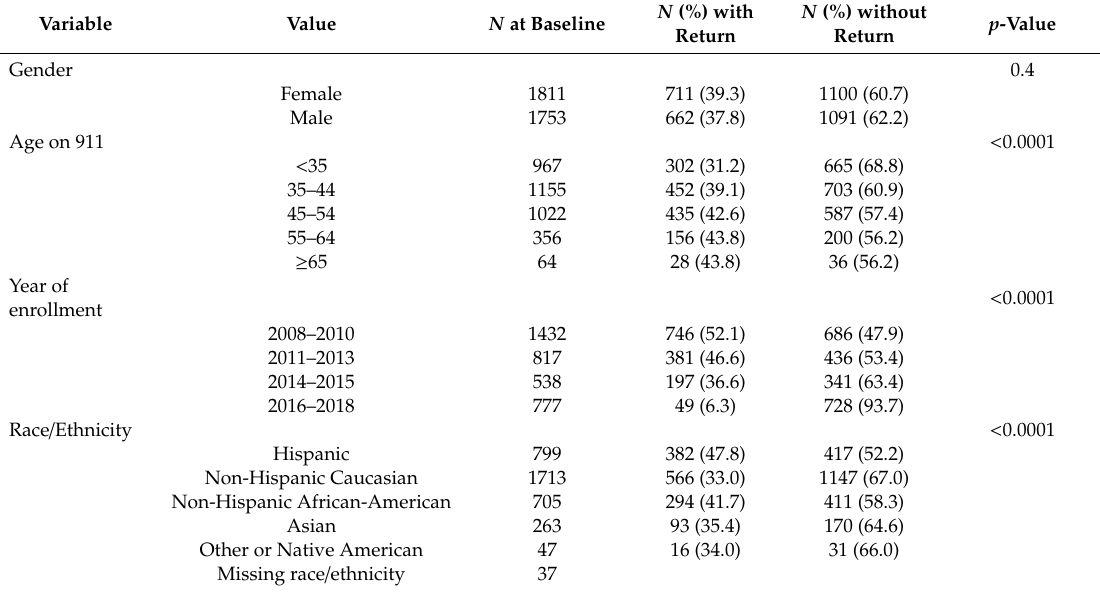
Table 1. Baseline characteristics associated with returning percentage for a return visit ( n = 3,564).